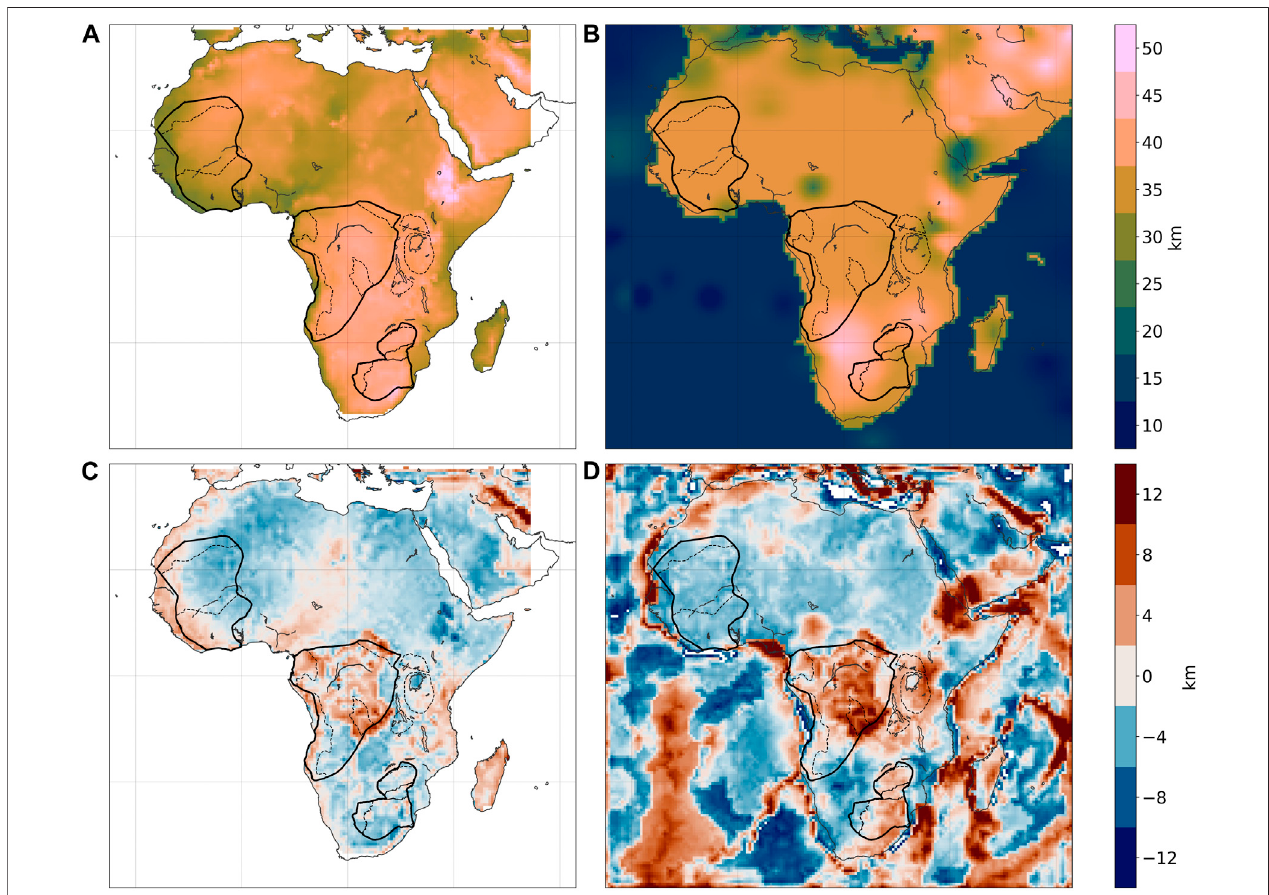
FIGURE 8 | Comparison of Moho depth models. (A) Moho depth model of Globig et al. (2016), which is only de fi ned for the African continent. (B) Moho depth model of Szwillus et al. (2019). (C) Difference of our estimated Moho model minus Globig-Moho. (D) Difference of our estimated Moho model minus Szwillus-Moho. Contours indicate cratons and shields, taken from Figure 6